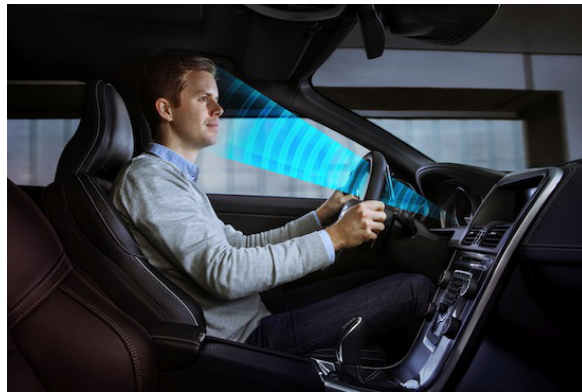
Figure 1: A driver camera can be used to extract features from images to recognize the driver intention of the next seconds as an important milestone to increase traffic safety (Volvo,